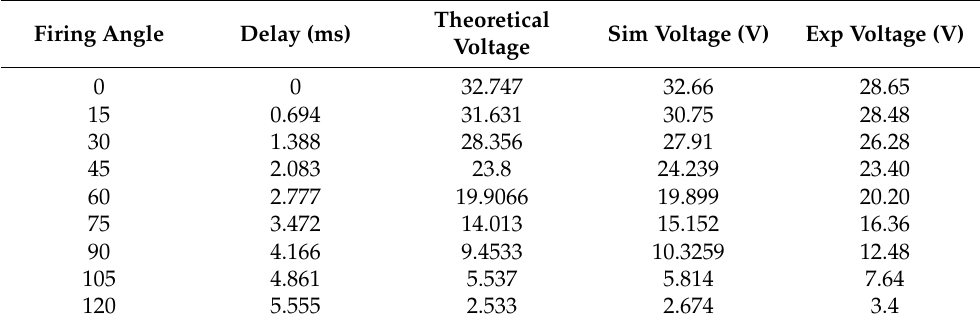
Table 4. Theoretical simulation and experimental measurements for the three-phase fully con- trolled rectifier.